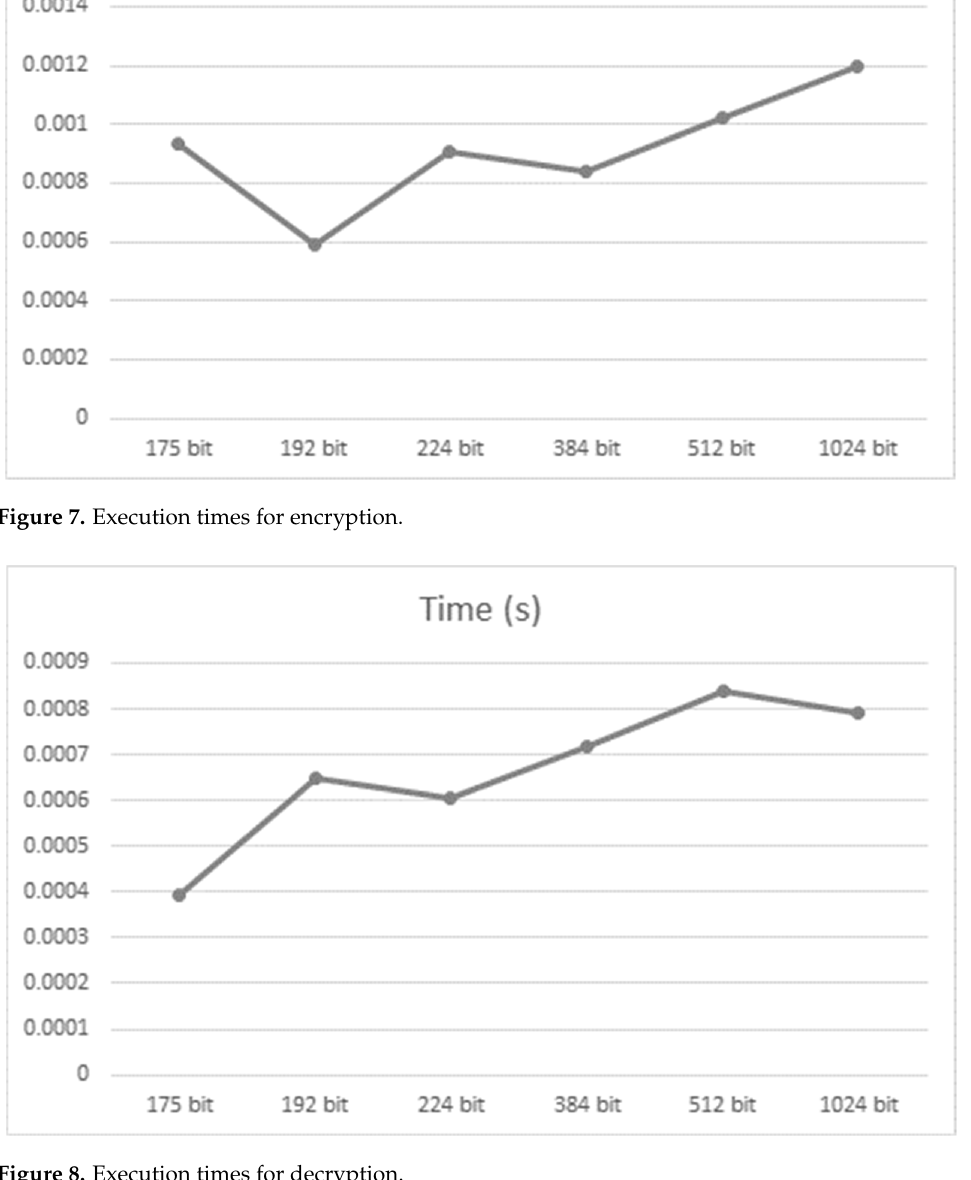
Figure 8. Execution times for decryption.